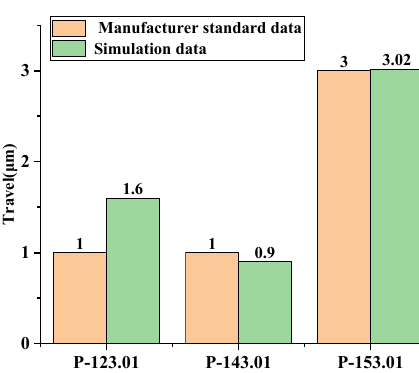
Figure 12. Schematic diagram of PIM travel.